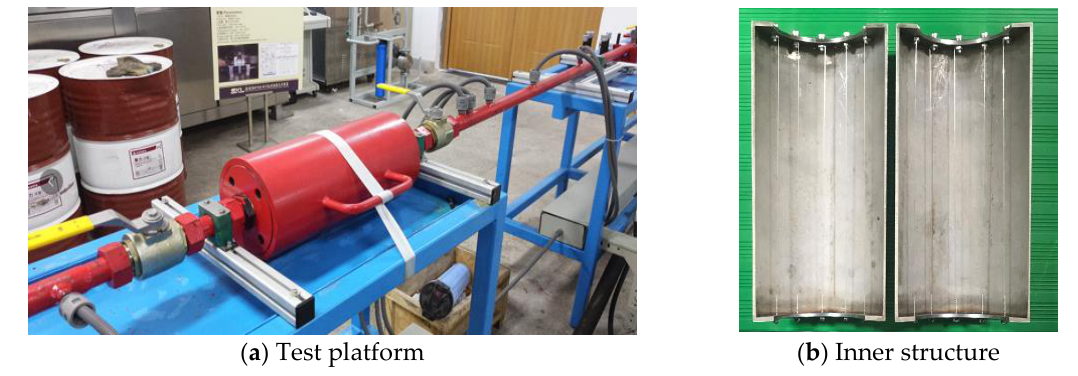
Figure 10. Experiment platform for testing the RSHPA.